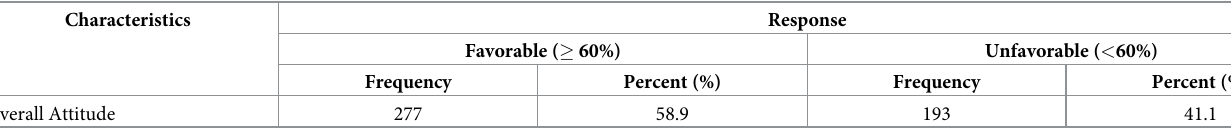
Table 9. Overall attitude of the respondents regarding e-learning (n = 470). Characteristics